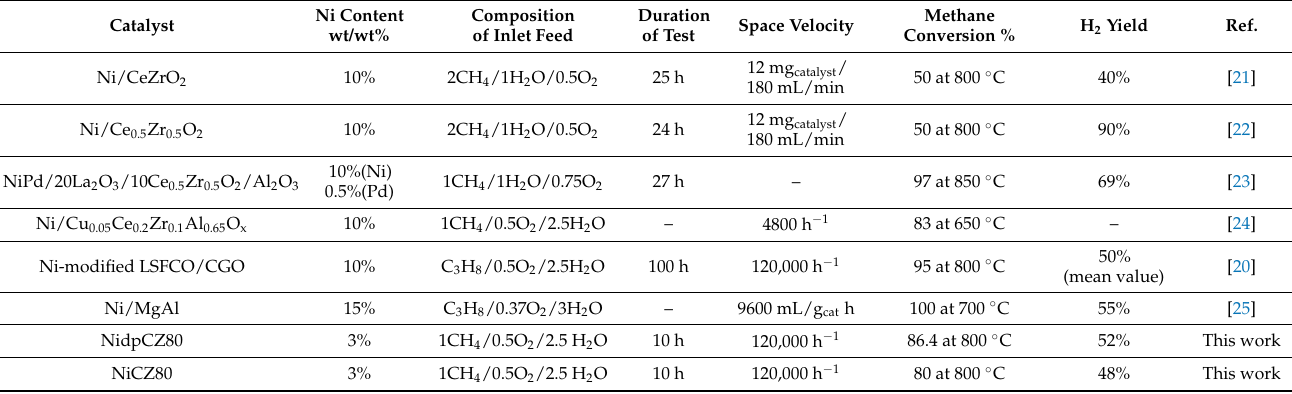
Figure 8. Products distribution for NiCZ80 and NidpCZ80 under ATR, SR, and POX conditions of methane at T = 800 °C, GSVH = 120,000 h − 1 . Table 1. List of the average conversion values of different fuels examined in ATR conditions on doped and undoped catalysts.